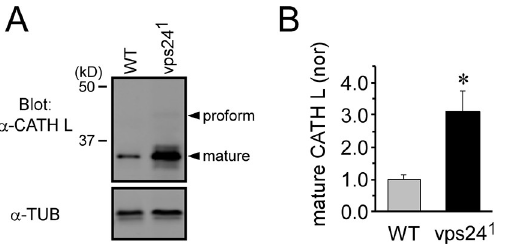
Fig 7. Normal proteolytic processing of Cathepsin L in the vps24 mutant. (A) Western blot analysis of endogenous Cathepsin L (CATH L) showing the proform and processed form of CATH L. Whole fly lysate from WT or the vps24 mutant was analyzed. In WT, the proform of CATH L is not visible in the image but is present at a detectable level. (B) Quantification of processed CATH L. The vps24 mutant exhibited significant accumulation of processed CATH L (3.1 ± 0.64 fold increase, n = 4) with respect to WT. However, the ratio of proform to processed form was similar in WT and the mutant [WT: 0.023 ± 0.004 (n = 5), 24 1 /Df: 0.013 ± 0.002 (n = 5), P = 0.062]. Tubulin (TUB) was used as a loading